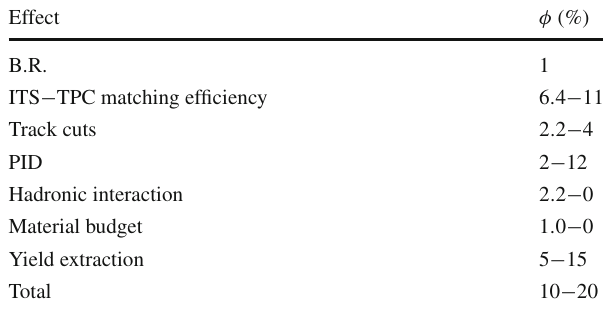
√ s NN = √ s NN = 5 . 02 TeV [11,26]. The